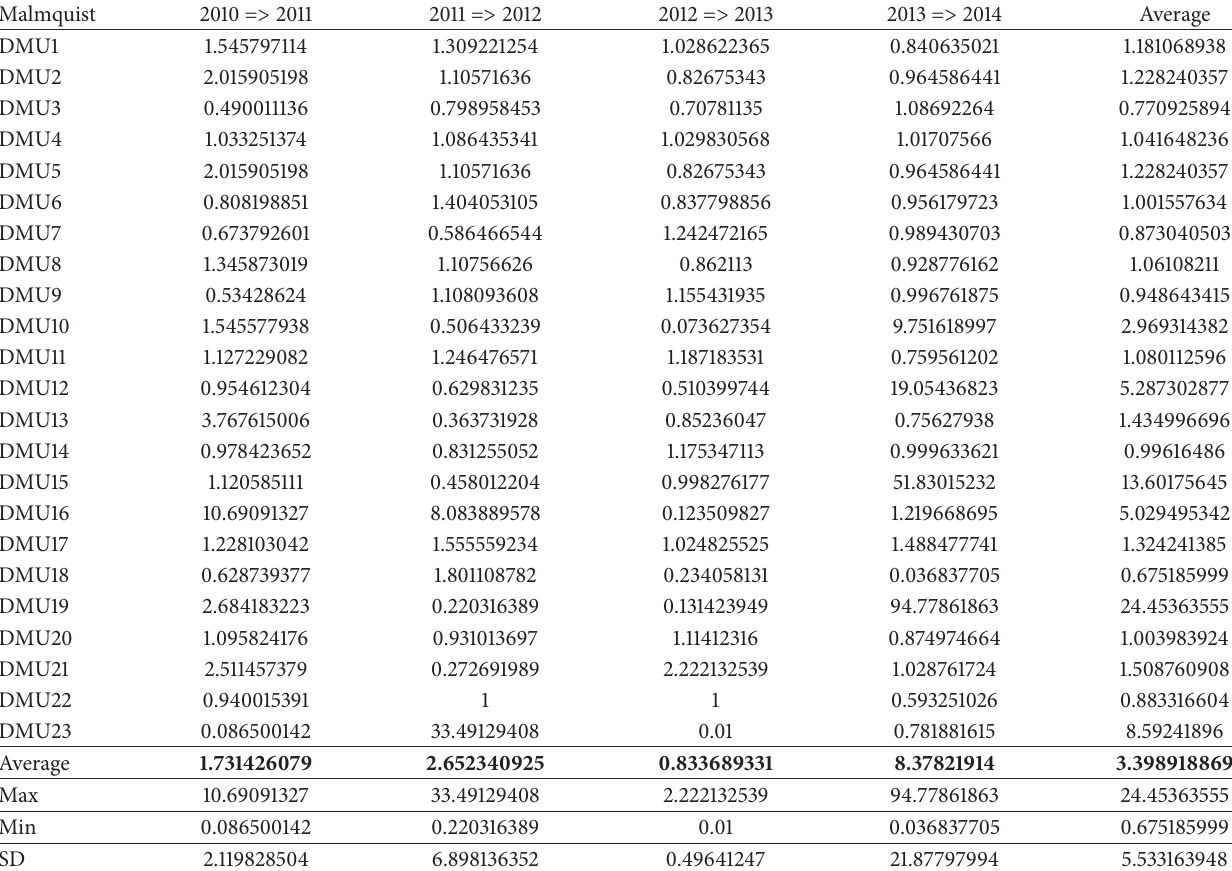
Table 15: Productivity index (Malmquist-MPI) change over the period 2010 to